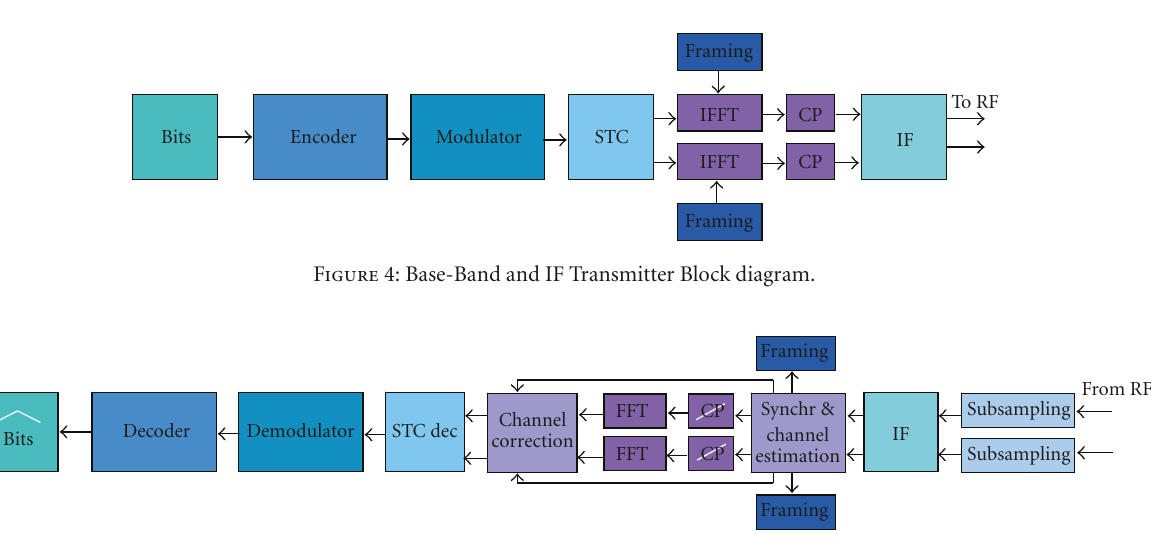
Figure 5: Base-Band and IF Receiver Block